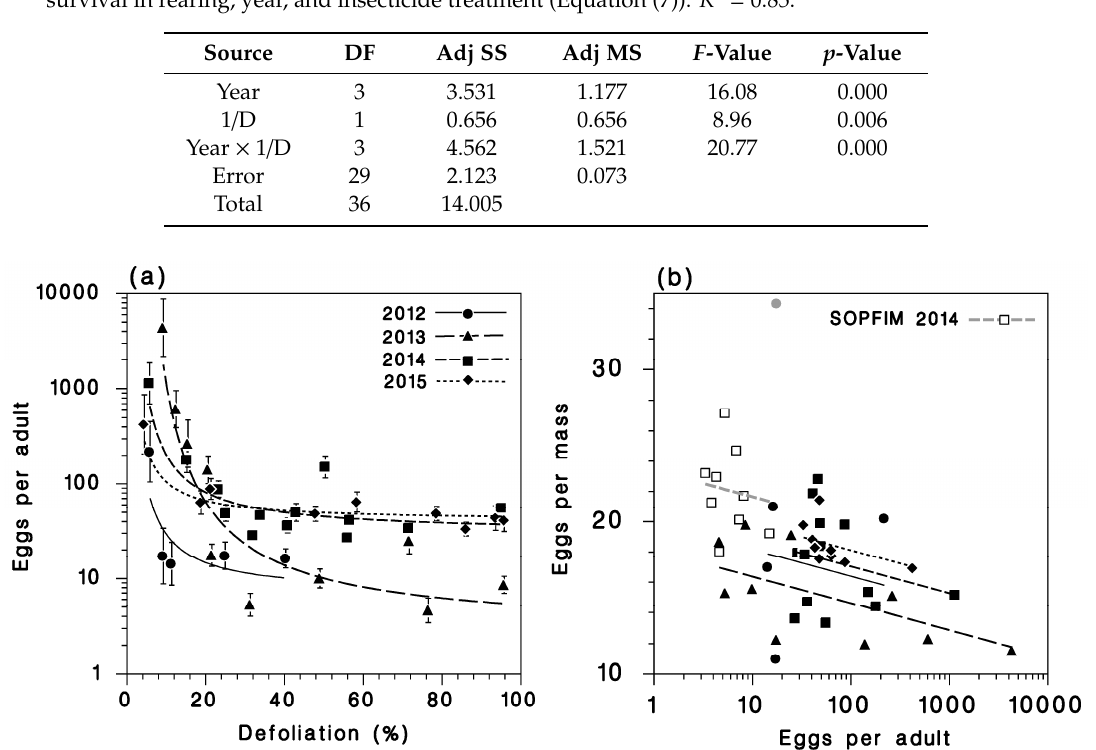
Table 5. Analysis of Variance table for log odds of survival in the field against log odds of combined survival in rearing, year, and insecticide treatment (Equation (7)). R 2 = 0.85.